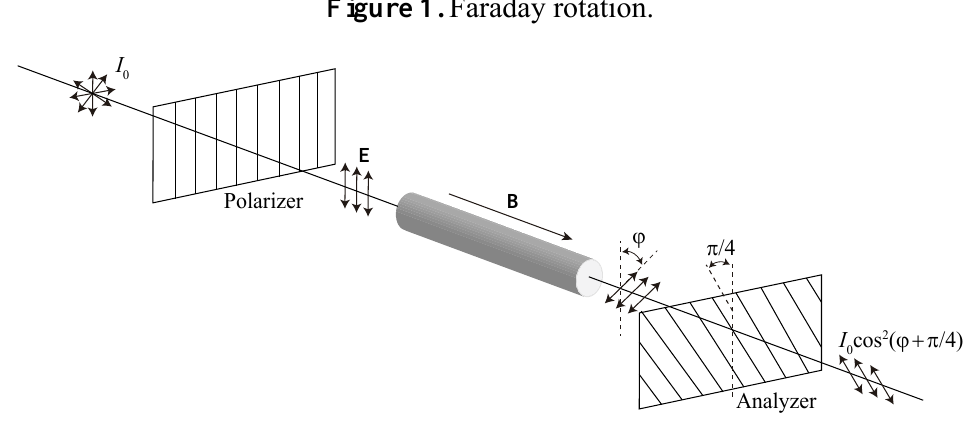
Figure 1. Faraday rotation.